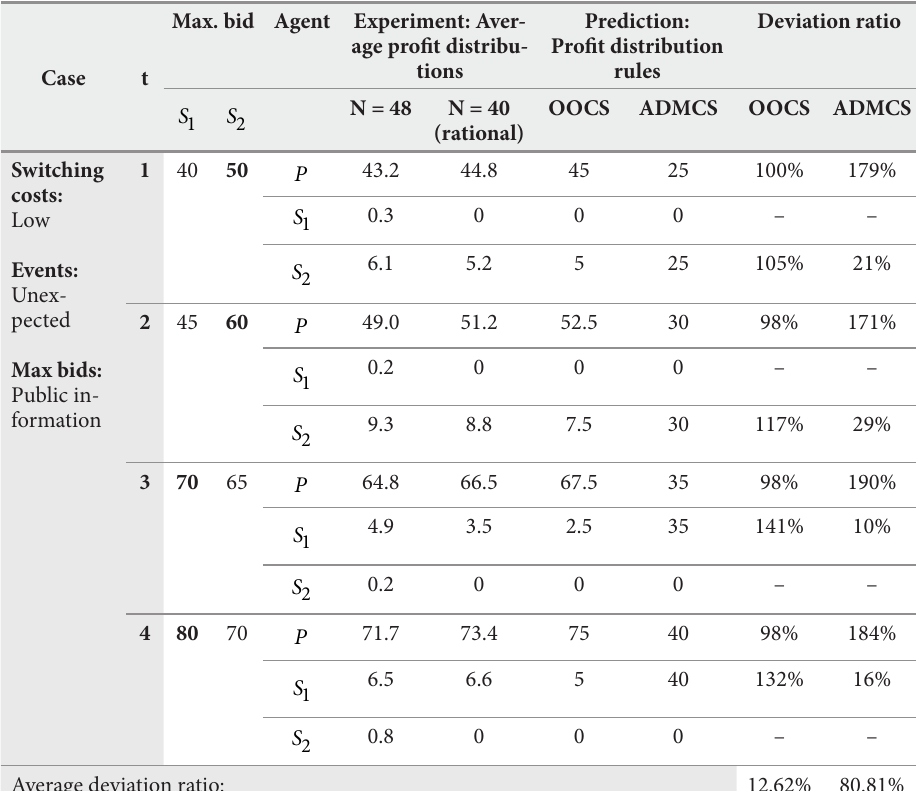
Table 3. Maximal bids and the comparison of the OOCS-rule and the ADMCS-rule with the empirical results for low agent switching costs and public information, unexpected events implicit Max. bid Agent Experiment: Aver- Prediction: age profit distribu- Profit distribution tions Case t